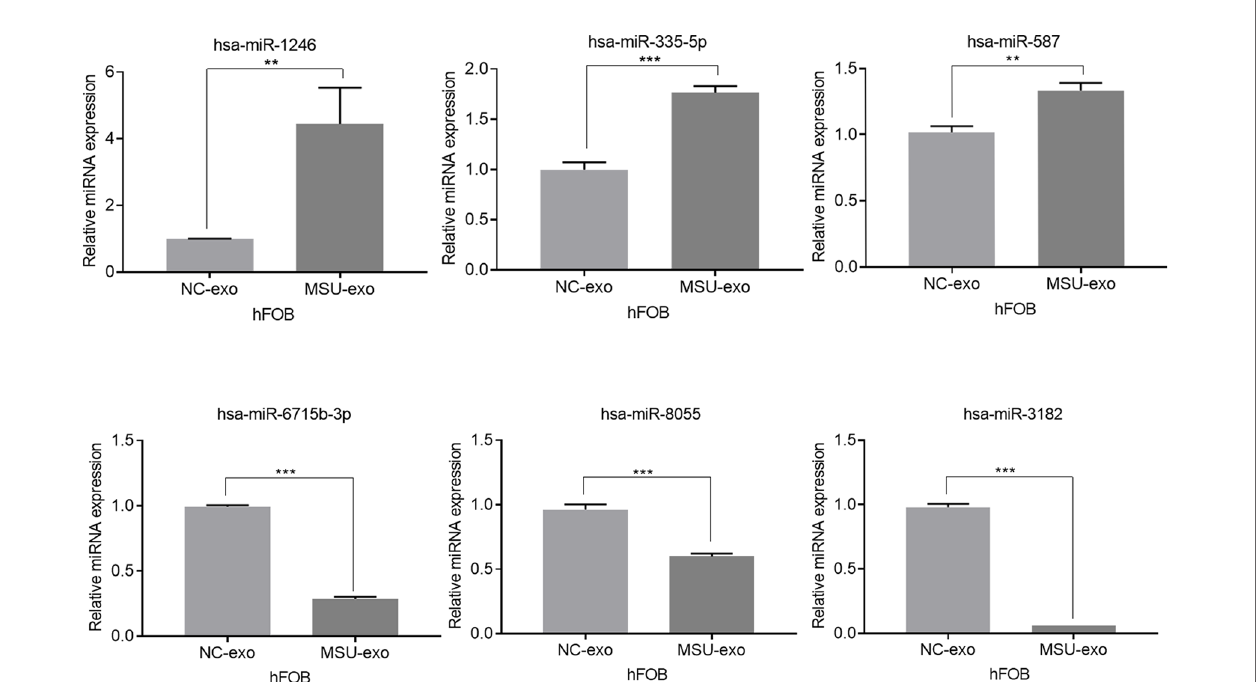
FIGURE 7 | The three miRNAs with the highest and lowest expression levels are veri fi ed (**P < 0.01, and ***P <